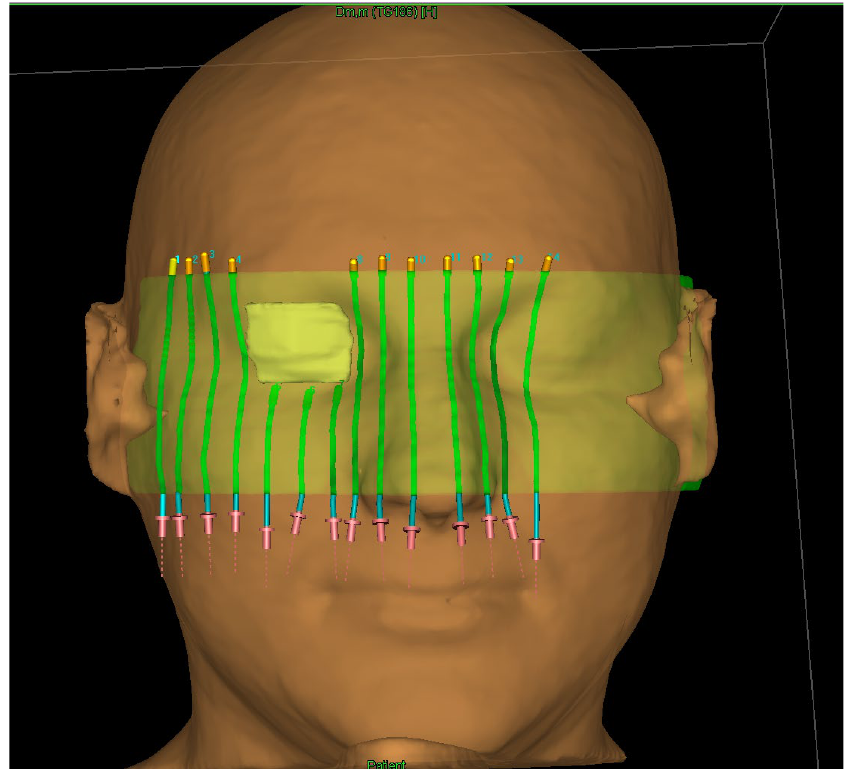
Figure 4. The applicator used for this study, with channels for brachytherapy catheters and space for the lead shield.